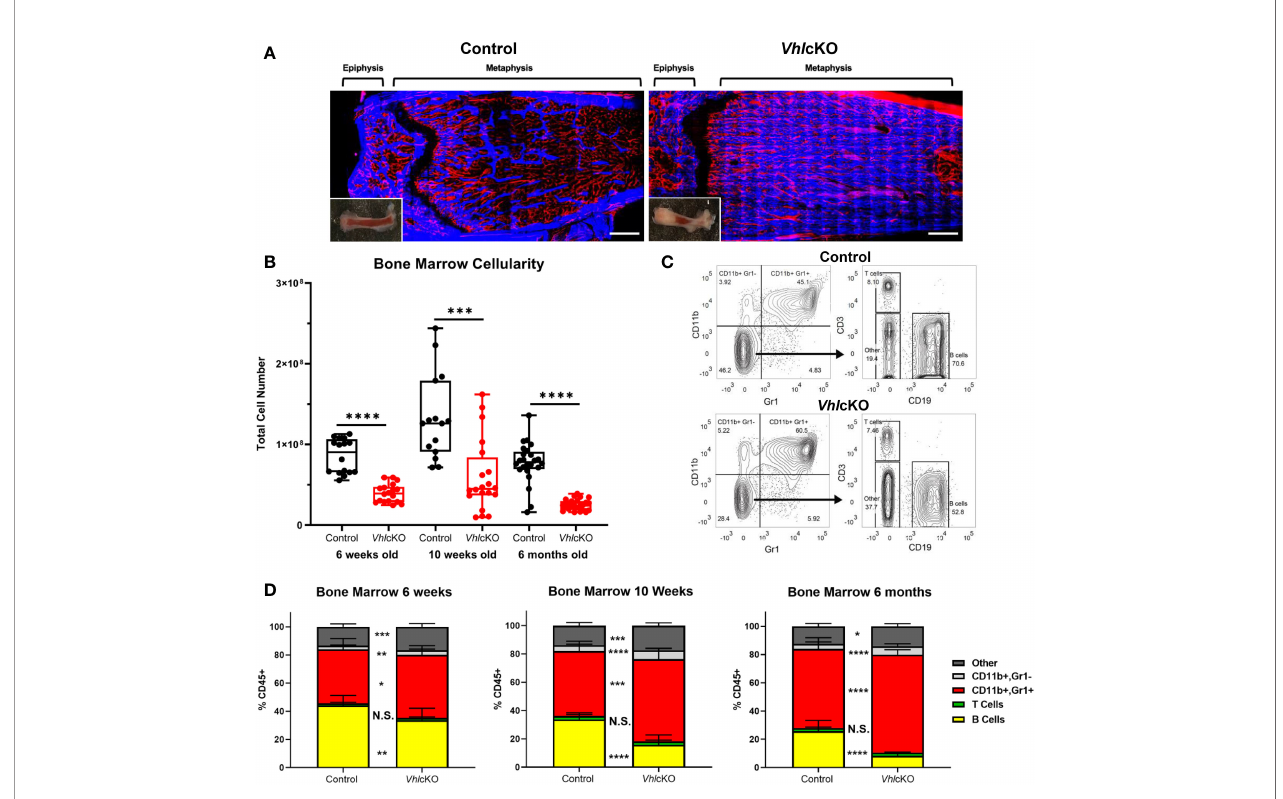
FIGURE 1 | Bone marrow, spleen and peripheral blood lineage cell defects in the Vhl cKO mice. (A) Macroscopic and ex vivo imaging of the distal end of long bones revealed progressive increases in the bone mass of 10-weeks-old Vhl cKO femurs compared to control. Inset: photo of the femur. Red: blood vessel (AlexaFluor647 CD31, AlexaFluor647 CD144, AlexaFluor647 Sca-1), Blue: bone (SHG). Scale bar ~500 m m; (B) bone marrow cellularity, (C) representative FACS plots of immune cell lineages, with the values on plots on the left representing cell frequency in total bone marrow, and the values on the plots on the right representing frequencies within the Gr-1- CD11b- gate. (D) frequency analysis of bone marrow lineage cells at 6-weeks of age (left), 10-weeks of age (middle) and 6-month (right). p<0.05*, p<0.01**, p<0.001***, p<0.0001**** two-tailed Student ’ s t-test. N.S., not statistically signi fi